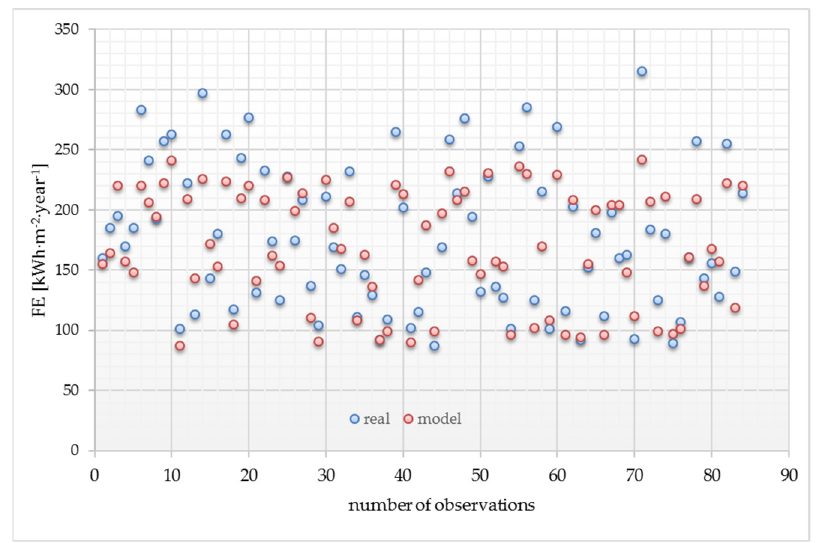
Figure 5. Comparison of actual final energy demand rate for heating with values obtained from model calculations.